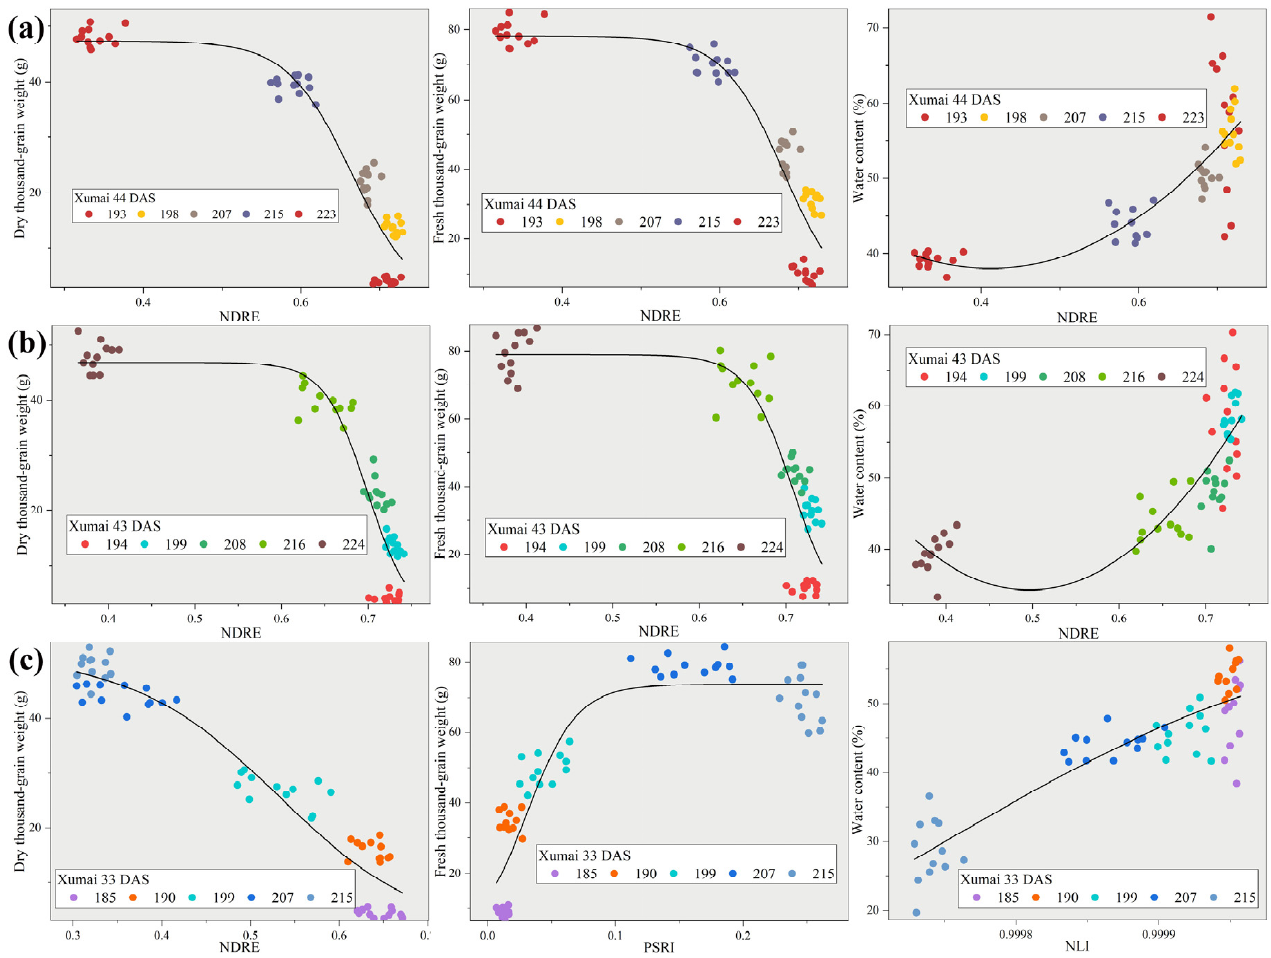
Figure 6. Monitoring models between three indicators of wheat grain-filling process and VIs during the growing season’s last five periods in Xumai 44 ( a ), Xumai 43 ( b ) and Xumai 33 ( c ). All samples were randomly divided into model development and model validation according to the ratio of 3:1. The number of validation samples for the overall model and the single-cultivar model was 60 and 20, respectively (Table 3). The 1:1 relationship diagrams between predicted values of established models and measured values were drawn to evaluate the accuracy of the monitoring models of grain-filling indicators (Figure